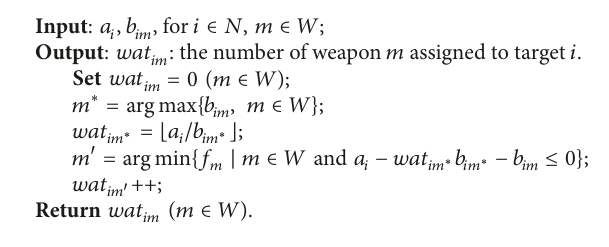
Algorithm 2: Procedure of the assigning strategy based on destroy effect.